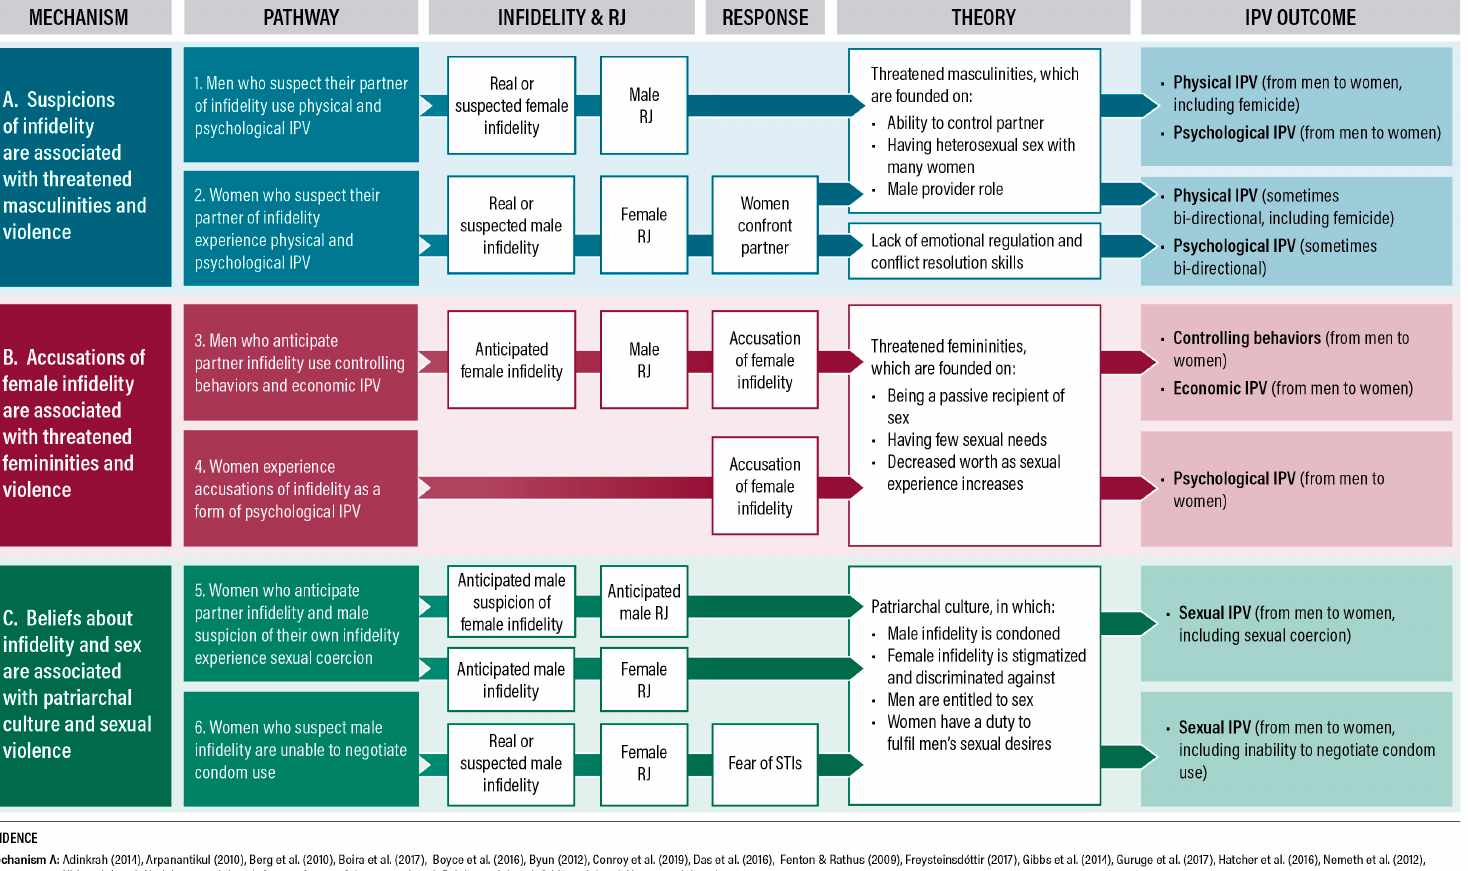
Figure 2. Identified mechanisms and pathways from infidelity and romantic jealousy (RJ) to intimate partner violence (IPV).